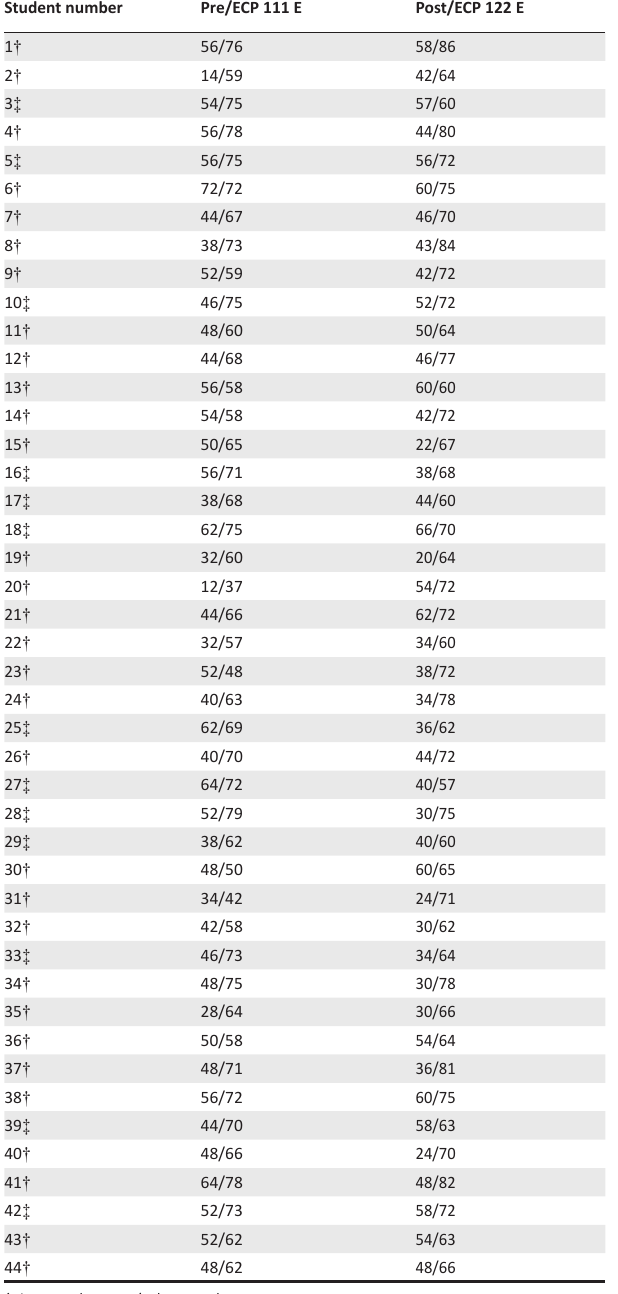
TABLE 1-A1: Reading programme pre- and post-test results for benchmark and class marks 2015: Pre- versus post-test and English course